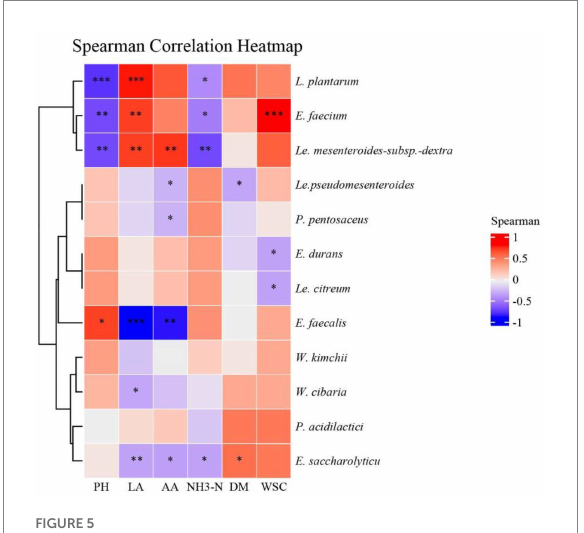
FIGURE 5 Spearman correlation heatmap of the lactic acid bacteria and fermentation products at species level. NH3-N, ammonia nitrogen; DM, dry matter; WSC, water-soluble carbohydrate; LA, lactic acid; AA, acetic acid. E., Enterococcus ; L. , Lactiplantibacillus . Le. , Leuconostoc ; W. , Weissella ; L. , Lactococcus ; P. , Pediococcus . * p < 0.05, ** p < 0.01, *** p <